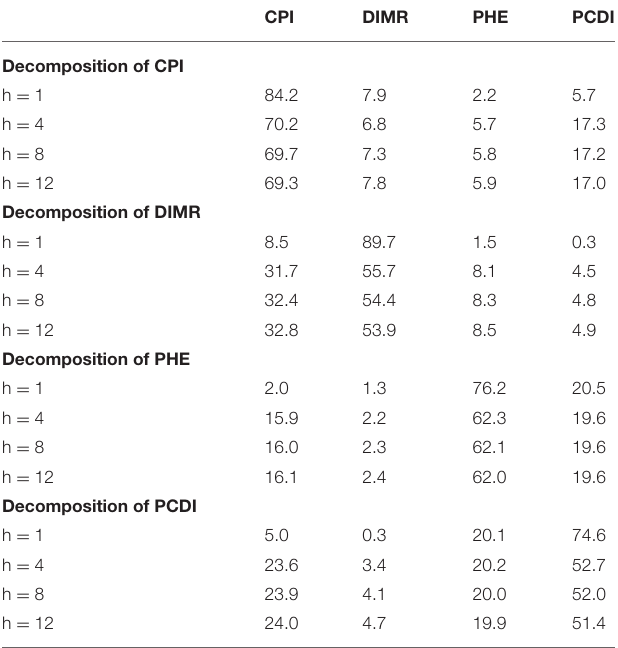
TABLE 4 | Forecast error variance decomposition of LF-VAR. CPI DIMR PHE